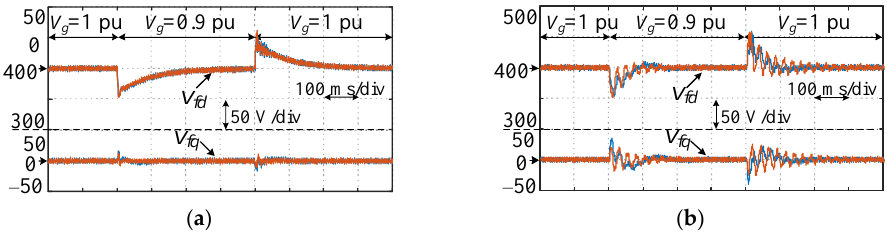
Figure 9. Time-domain simulations showing the system response for 10% voltage sag at grid voltage under different power levels ( P = 0.25 P n (orange) and P = 0.75 P n , (blue)). ( a ) SCR = 5; ( b ) SCR = 1.67.